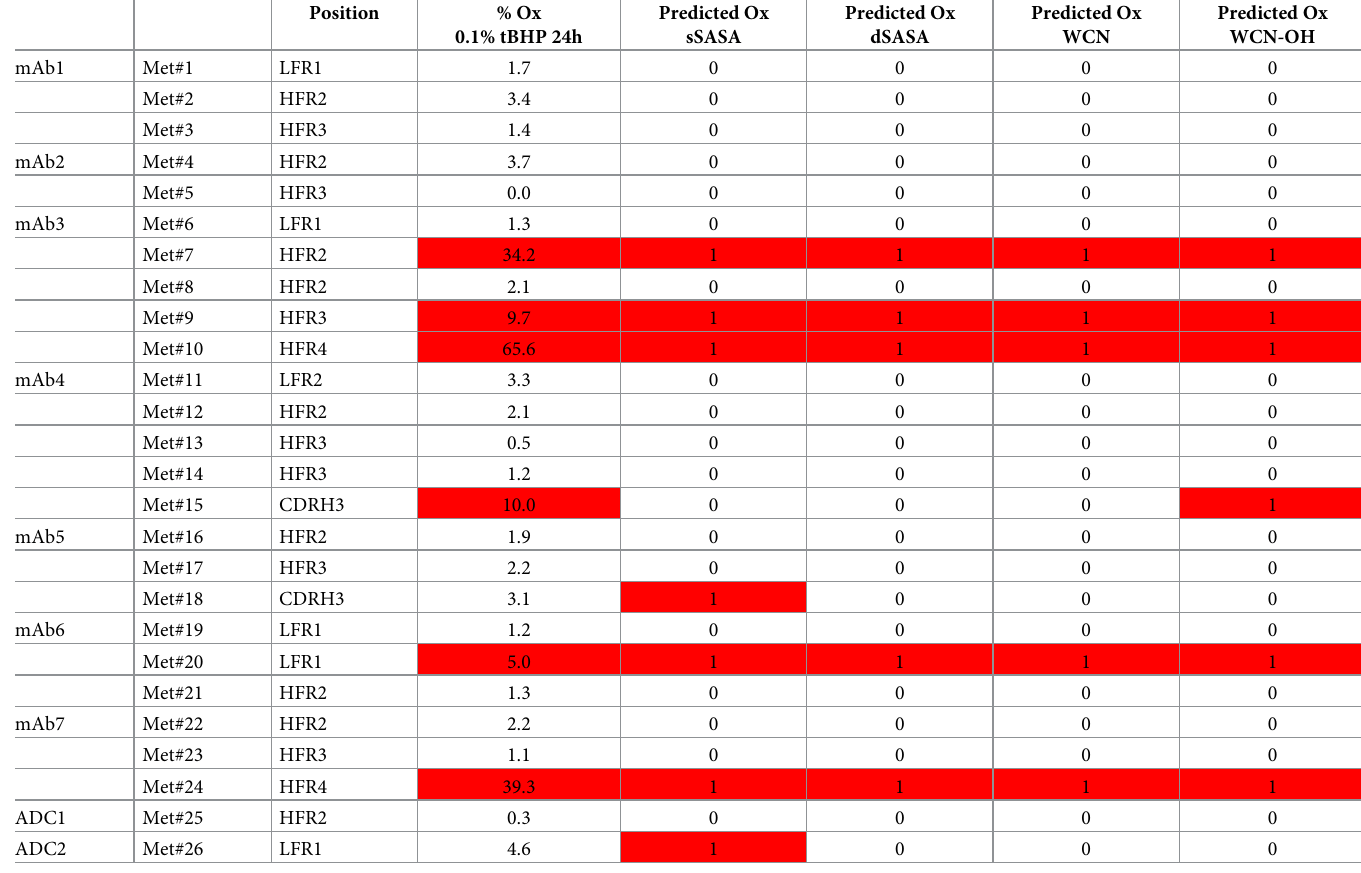
Table 4. Comparison of experimental results and in silico prediction of oxidation events for the 7 mAbs and 2